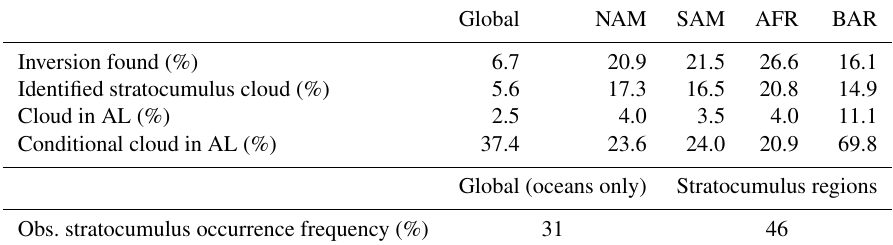
Table 2. Global and regional average occurrence frequency in the SC-VOLUME simulation of finding an inversion, finding an inversion with an underlying cloud (identified stratocumulus clouds), and finding a cloud in the ambiguous layer (AL); and the conditional occurrence frequency of a cloud in the ambiguous layer, given that a cloud is present below the inversion. Also included for comparison are the average frequency of occurrence of stratocumulus clouds from the Hahn and Warren (2007) surface-based observational cloud climatology, averaged over the stratocumulus regions defined in this